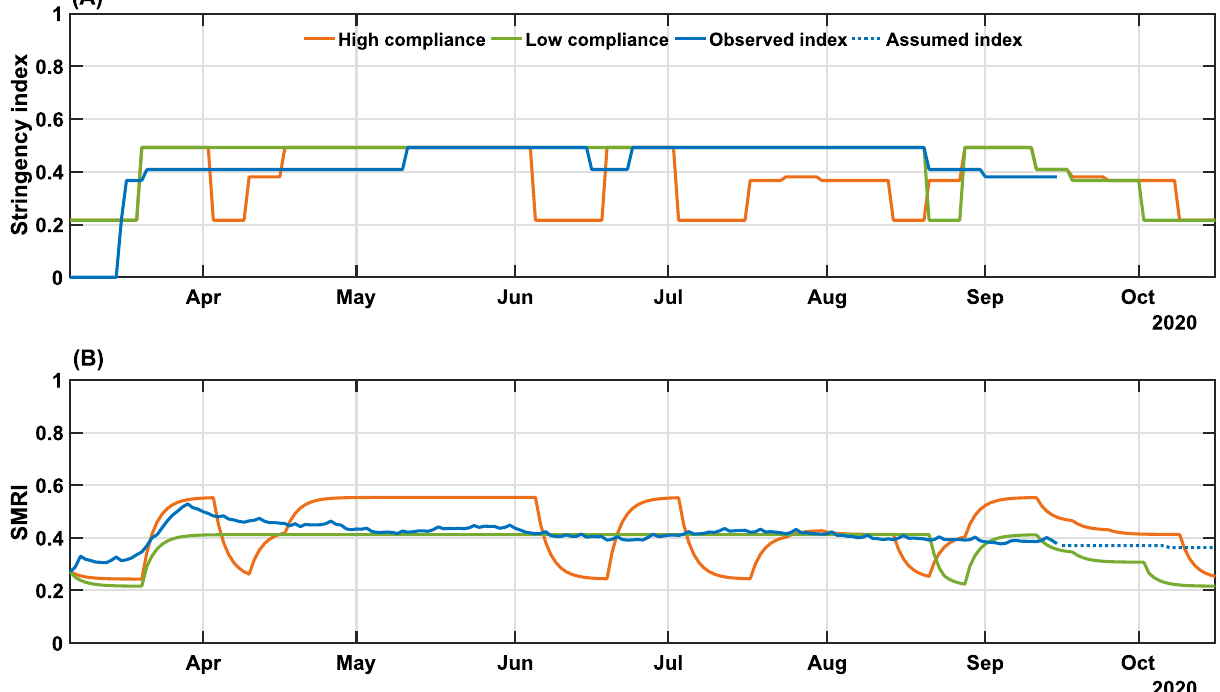
Figure 4. Real and simulated social mobility and governmental interventions in the state of Bahia. Levels of stringency ( A ) and social mobility reduction ( B ) indexes are shown for the high and low compliance scenarios, as well as the actual value of these metrics in the state-level during the period. The observed SMRI values (March 6-September 15) consist of a 8-day moving average. The dotted line in panel ( B ) indicates the assumed values of SMRI as described in Results. The high ( K ψ = 1.1247 ) and low ( K ψ = 0.8374 ) compliance scenarios represent the level of social mobility response related to the applied government